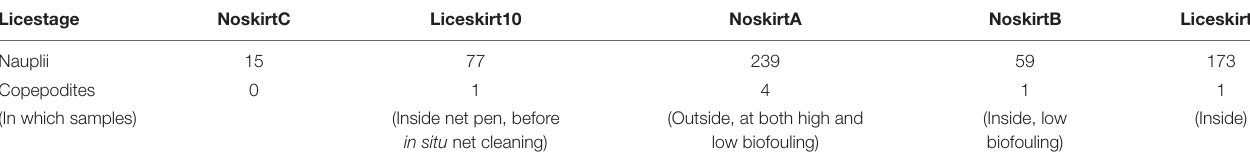
( Figure 2D ). For Liceskirt10, the proportion-non-zero data did not allow the calculation of individual odds ratios for each sample time due to a violation of the minimum expected frequency assumption. Differences between sample times were, however, rather small compared to differences between sample points (inside vs. outside, Figure 3C ). When all inside samples were compared with all outside samples at Liceskirt10, there was a significantly higher likelihood of finding planktonic sea lice in samples from the inside than in samples from the outside ( Table 3 ). For plankton samples from this site, only one copepodite was found (inside the net pen, before in situ net